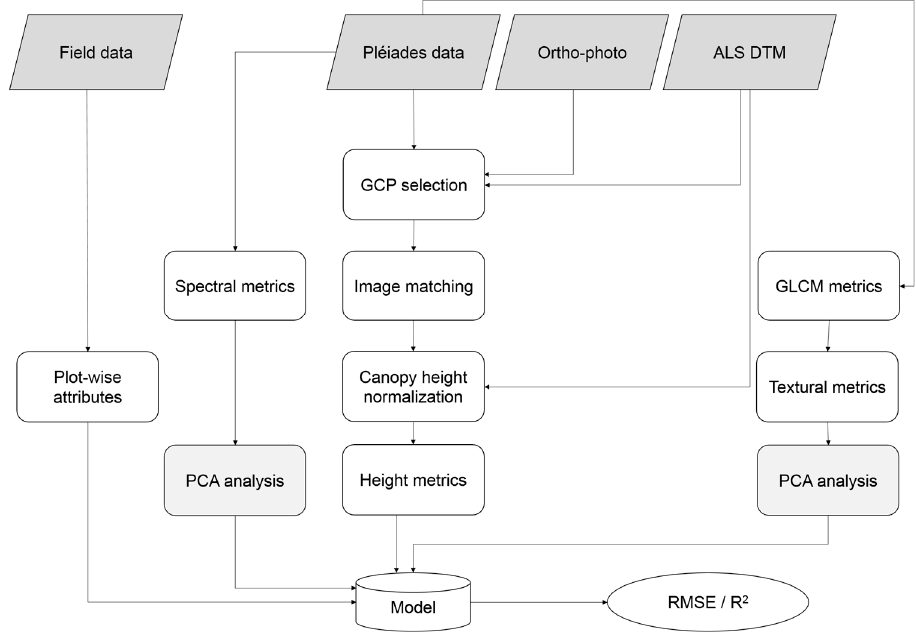
Figure 4. Methodological workflow for this study.